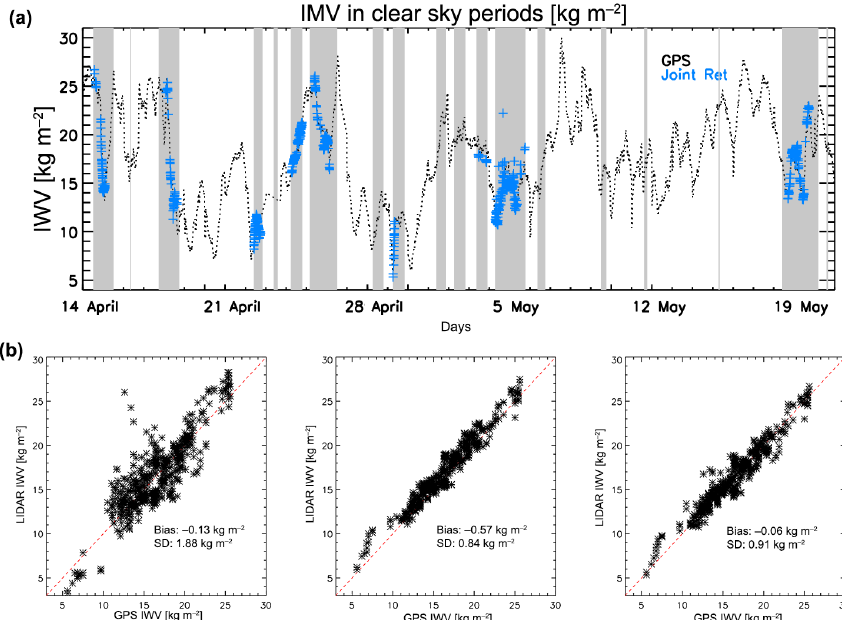
Figure 5. (a) Time series of IWV during the whole HOPE period from the continuous GPS signal (black) and the one calculated from the joint retrieval, which is available only in clear sky cases (blue). Shaded areas represent the RL availability. (b) Scatter plot for the three cases: only Raman lidar, only MWR and the joint retrieval (from left to right), against the